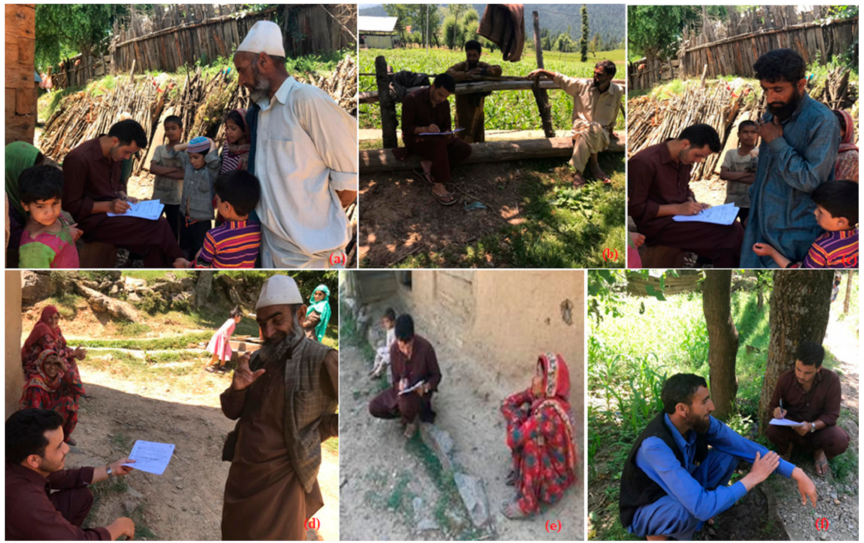
Figure 2. Snapshots during the interviews of local participants for medicinal plants ( a – f